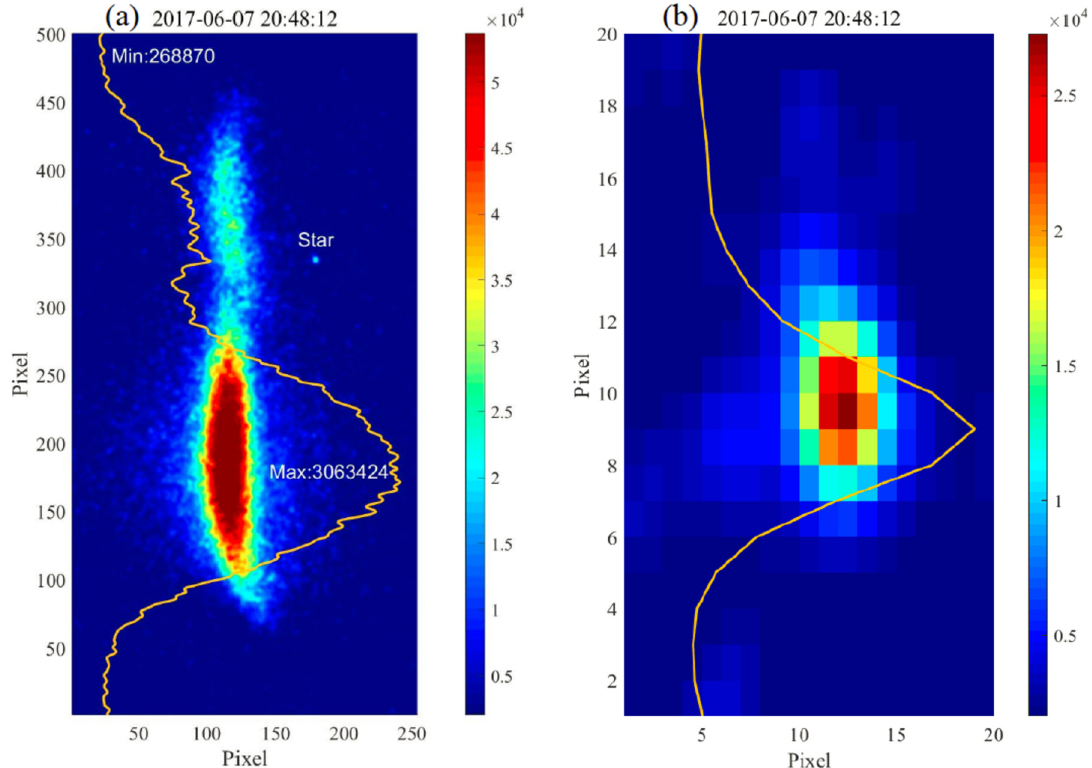
Figure 5. The simultaneous Rayleigh spot around 20 km altitude (80–300 pixel vertical) and Na spot (320–425 pixel vertical) averaged between altitudes of ~80 km and 120 km. The unit of both axes is “number of pixel”. The image to the right is a zoomed-in picture of a star that happened to be in the FOV during the experiment.